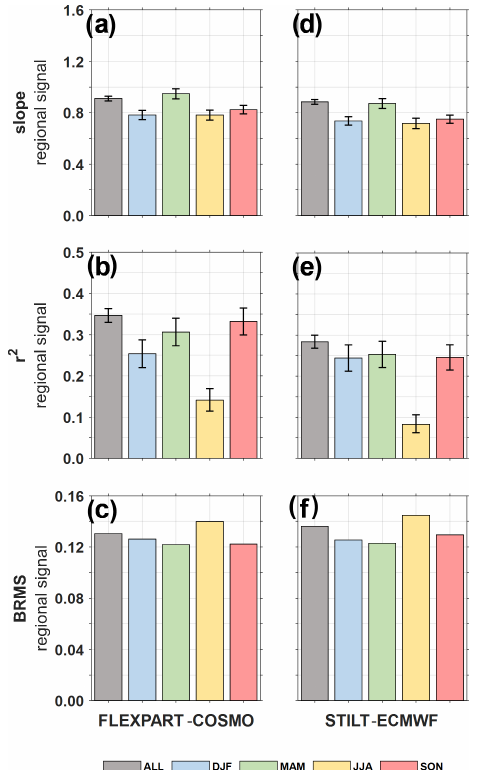
Figure 9. Summary of the regression analysis of δ 13 C–CO 2 esti- mation vs. observation (data are based on 3-hourly time resolution; error bars show the 95% confidence interval). Performance param- eters (slope, r 2 and bias-corrected RMSE – i.e. BRMS) are pre- sented for the 4-year subset of the observation period (2012–2015) for FLEXPART–COSMO (a–c) and STILT-ECMWF (d–f) across all years (ALL) and per season (DJF, MAM, JJA,